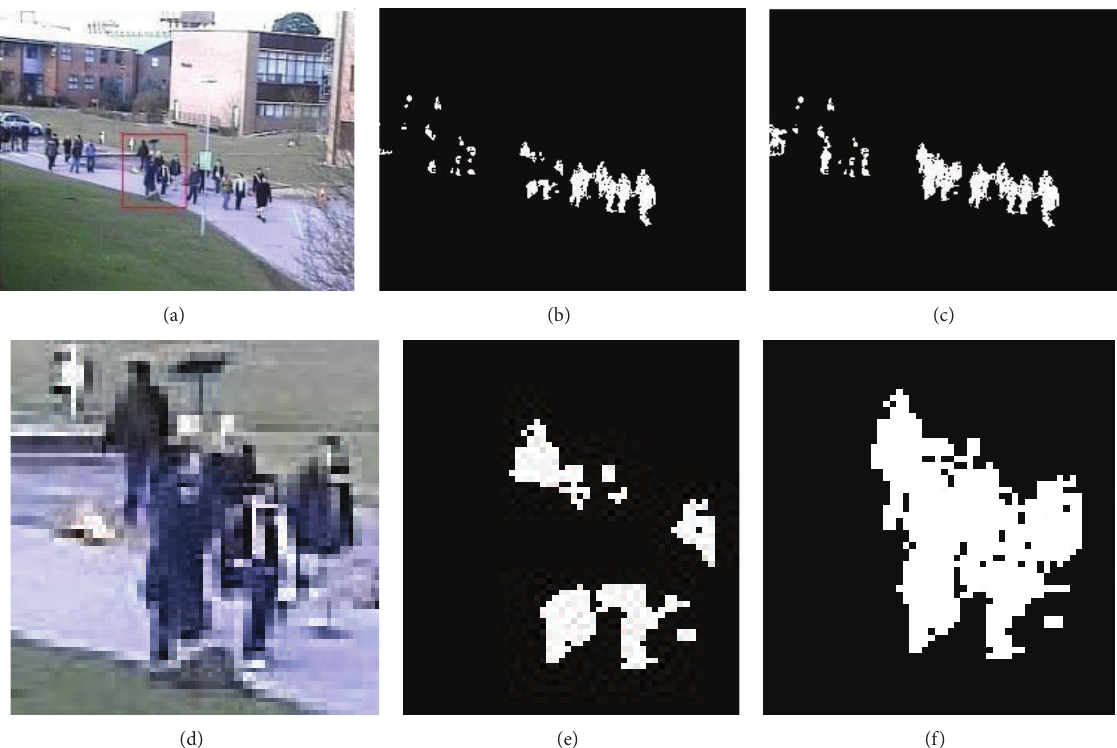
Figure 4: Comparison of MOG and “MOG with blob tracking”: (a) a frame (number 094) from the video with crowded people, (b) result of original MoG, (c) result of MoG with blob tracking, and (d), (e), and (f) in the bottom are the detail of center part of the above images.